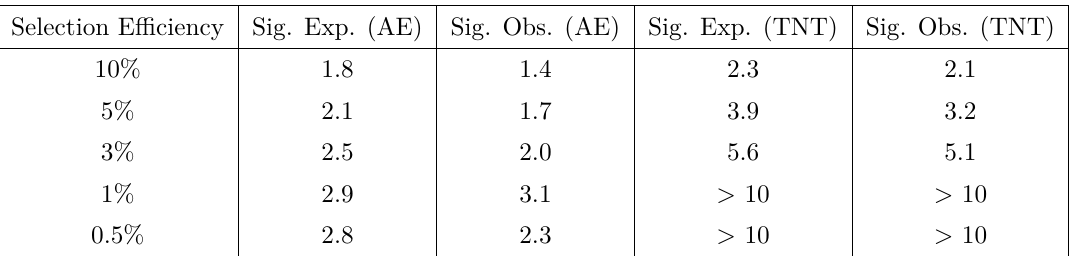
Table 1 . A rough comparison of the expected and observed significance (in σ ’s) for the autoencoder and Tag N’ Train based searches on a dataset with 1% signal. The shown significance is based on the total uncertainty on the background estimate and the Poisson uncertainty on the number of observed